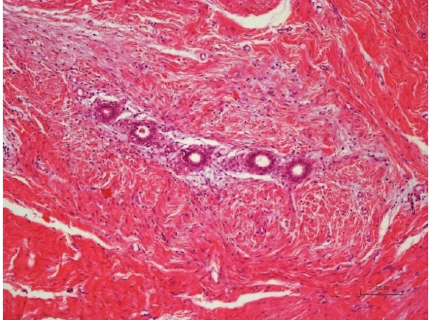
Figure 4: Endometrial glands and stroma (H&E, × 10).